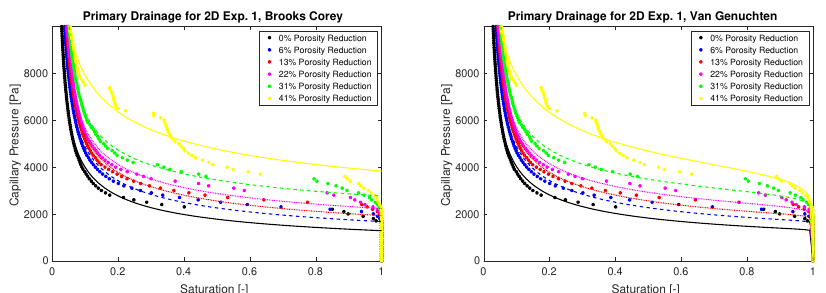
Figure 6. Capillary pressure–saturation relations for Experiment 2D1 at various porosity reductions as fitted with Brooks–Corey (Equation (4)) ( left ) and Van Genuchten relation (Equation (5)) ( right